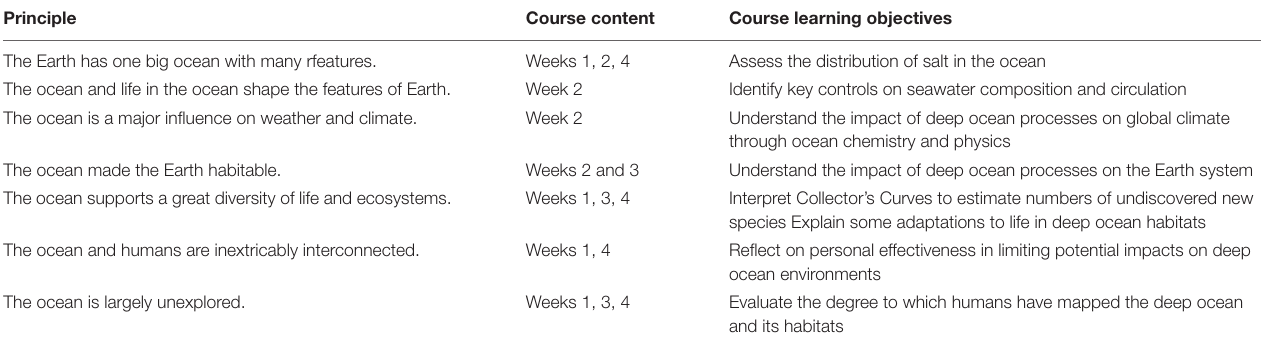
TABLE 1 | Exploring our Oceans course design mapped against Principles of Ocean Literacy. Principle Course content Course learning